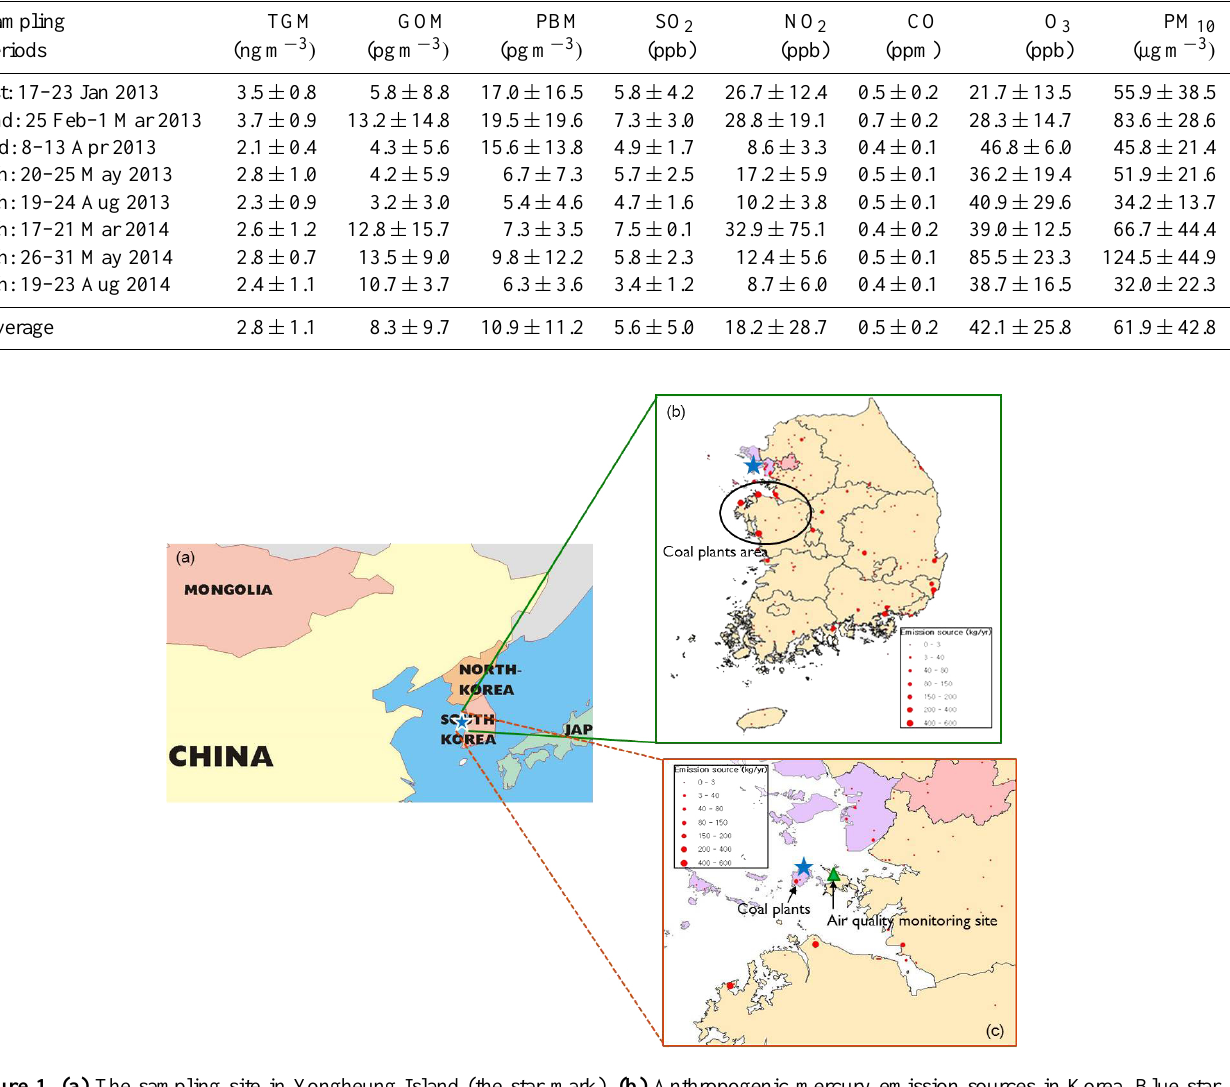
Figure 1. (a) The sampling site in Yongheung Island (the star mark). (b) Anthropogenic mercury emission sources in Korea. Blue star indicates the sampling site, and the green circle indicates the area where major Korean coal-fired power plants are located. (c) The enlarged image of the area near the sampling